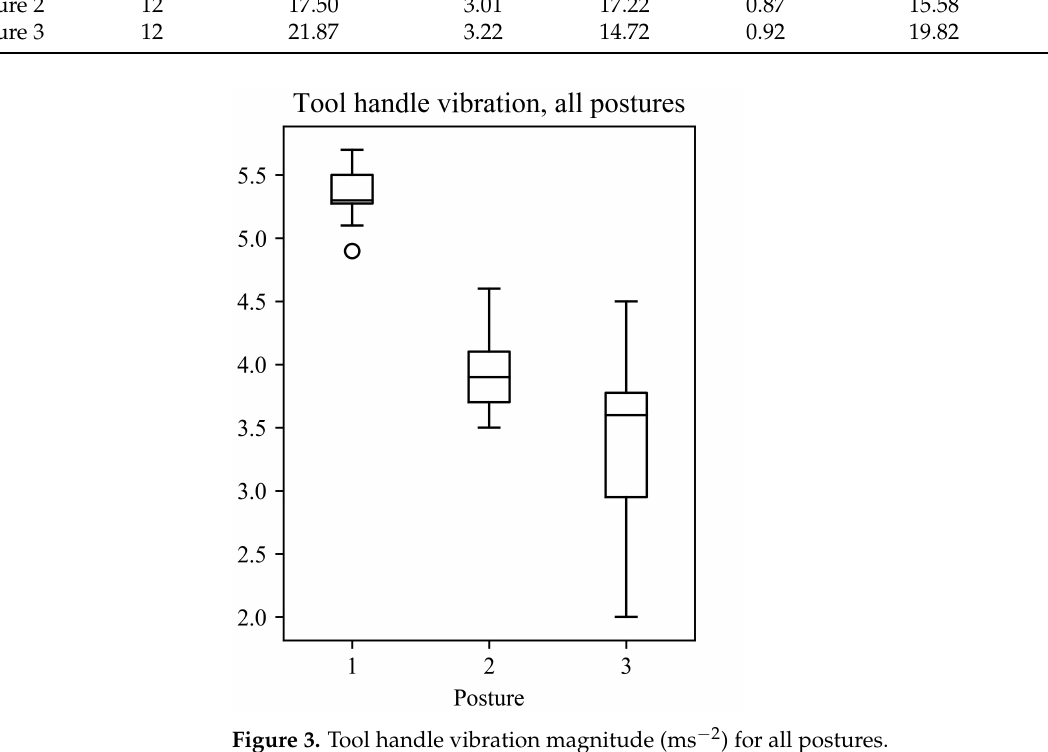
Figure 3. Tool handle vibration magnitude (ms − 2 ) for all